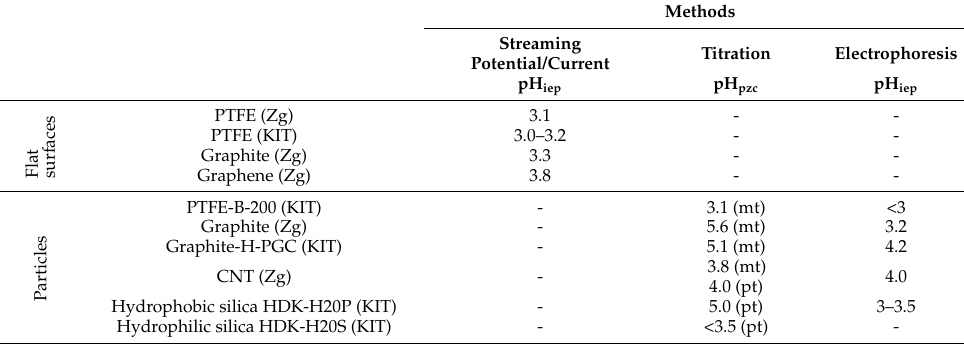
Table 4. Determined values of pH iep and pH pzc for different inert materials in aqueous NaCl solutions, θ = 25 ◦ C. For the titration results in brackets, we indicate whether the results stem from potentiometric mass titrations (mt) or from acid–base titrations (pt).